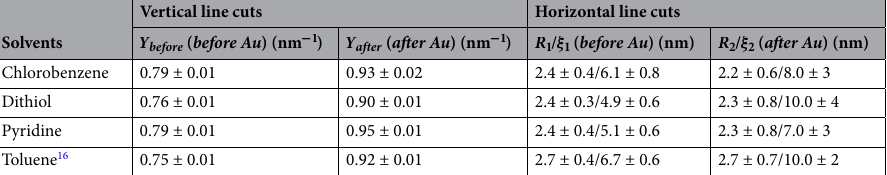
Table 1. One-dimensional vertical line cuts along Q z at Q y = 0.0 nm − 1 yielding the Yoneda maxima (Y before ) before and (Y after ) after Au deposition. The data are tabulated for different solvents. Fit parameters, R 1 , R 2 and ξ 1 , ξ 2 , extracted from the one-dimensional horizontal line cuts along Q y before and after Au deposition at certain Q z values, corresponding to their respective Yoneda peak positions (Y before , Y after